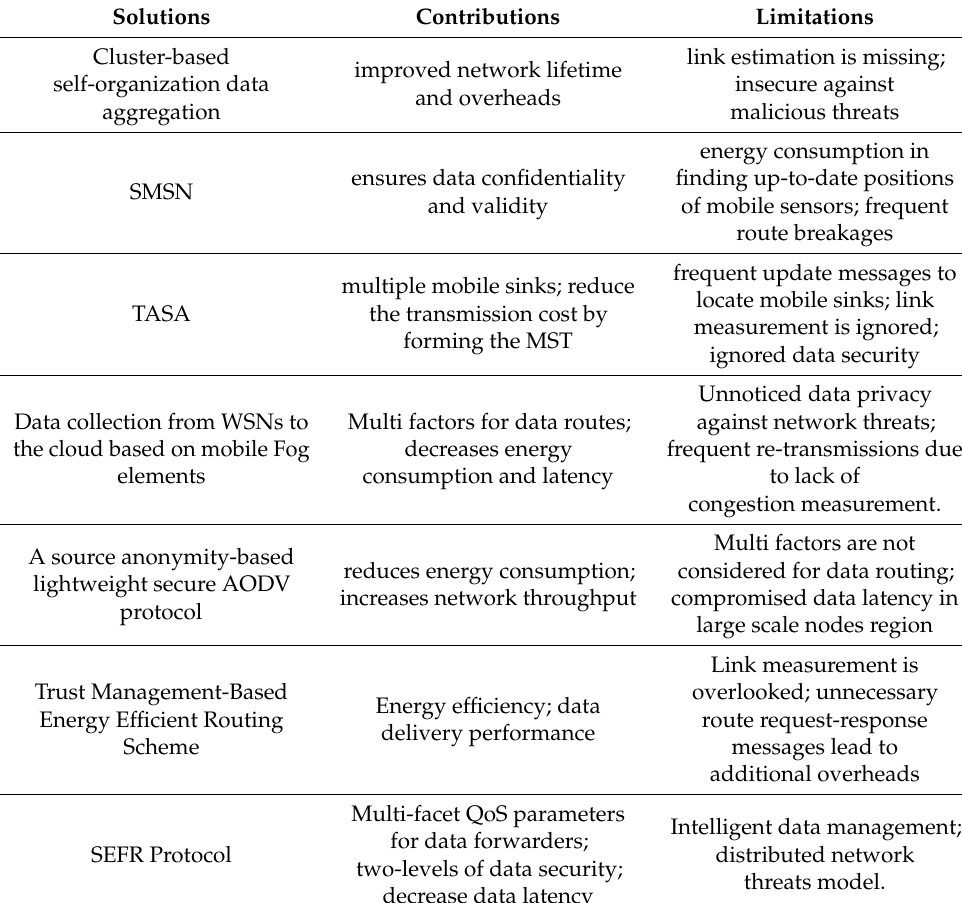
Table 1. Solutions